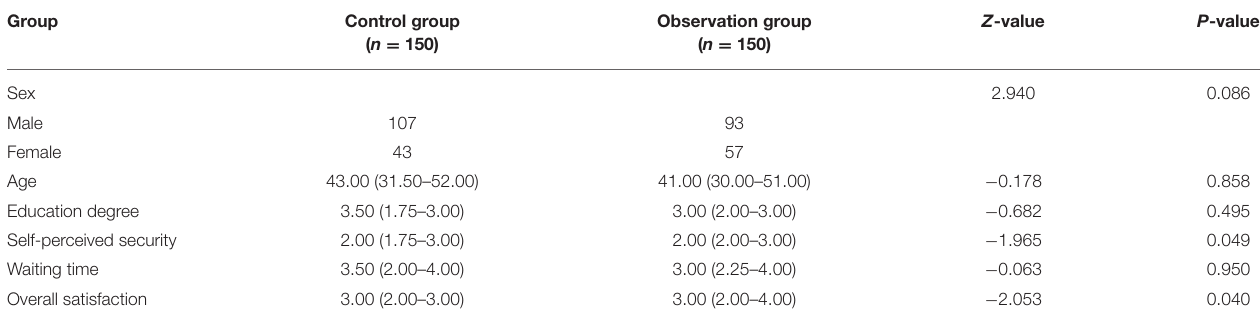
TABLE 4 | Comparison between two groups of people requiring nasopharyngeal swabs. Group Control group